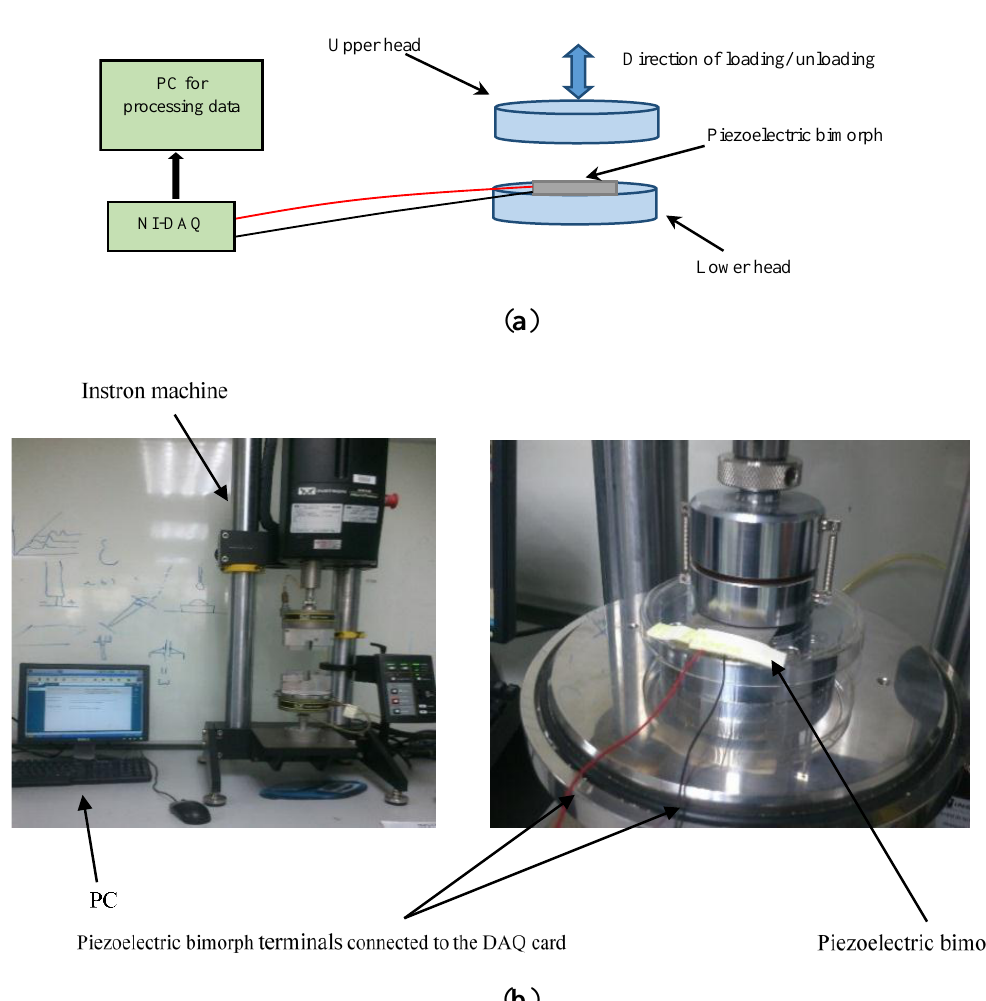
Figure 2. Overall diagram of the sensor calibration. ( a ) Simple schematic illustrating the calibration experimental setup; ( b ) Experimental